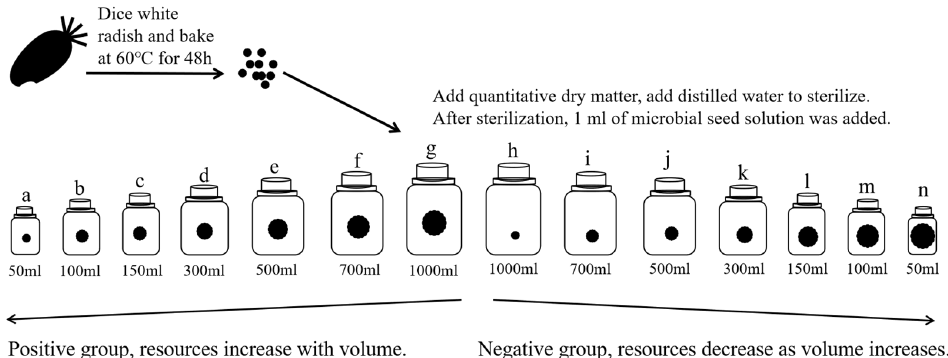
Figure 2. Schematic diagram of the experimental design. a–n is the id of each experimental group